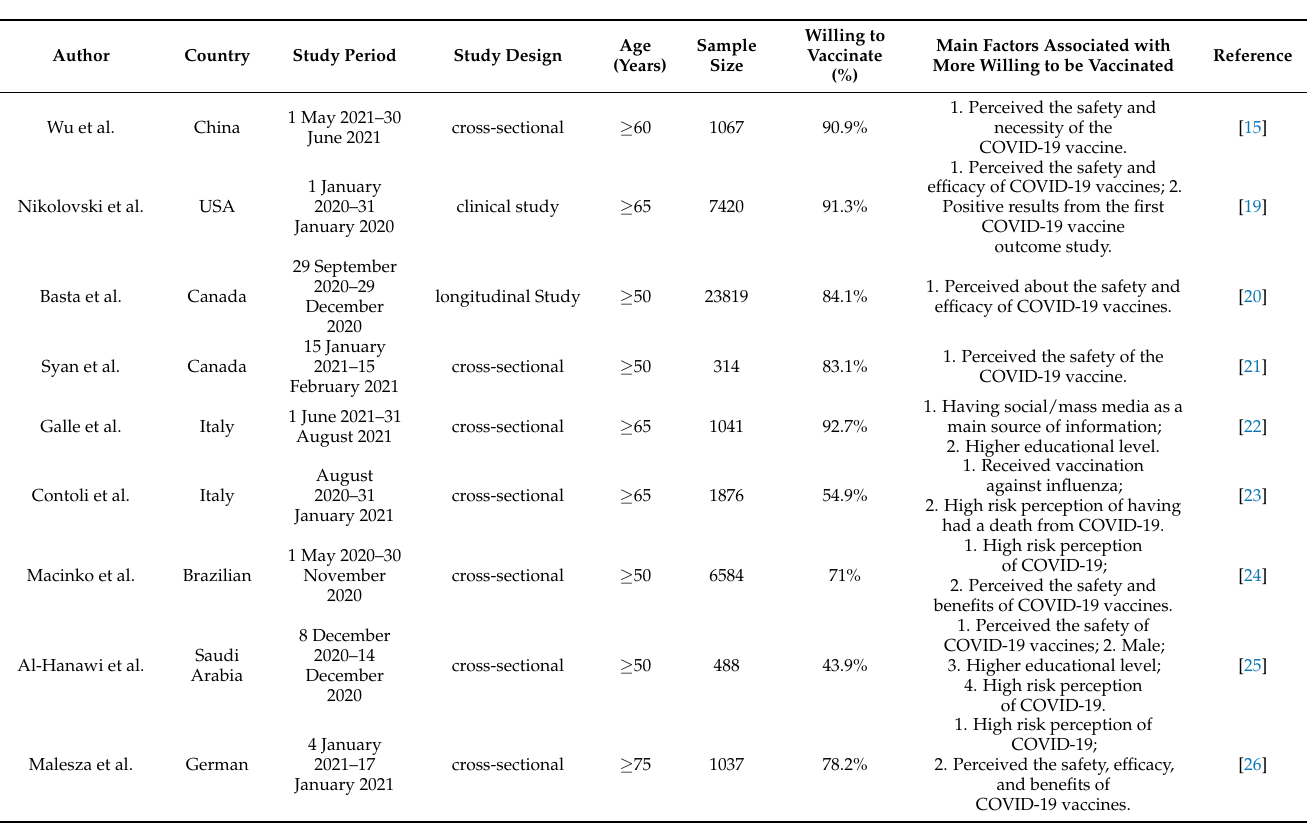
Table 4. The estimates of older adults’ willingness to receive the primary dose of the COVID-19